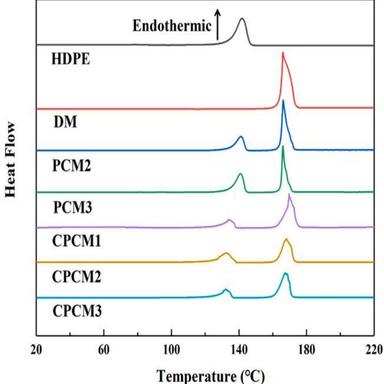
Melting DSC curves of the HDPE, DM, PCMs, and CPCMs. Fig. 8. Solidifying DSC curves of the HDPE, DM, PCMs, and CPCMs.